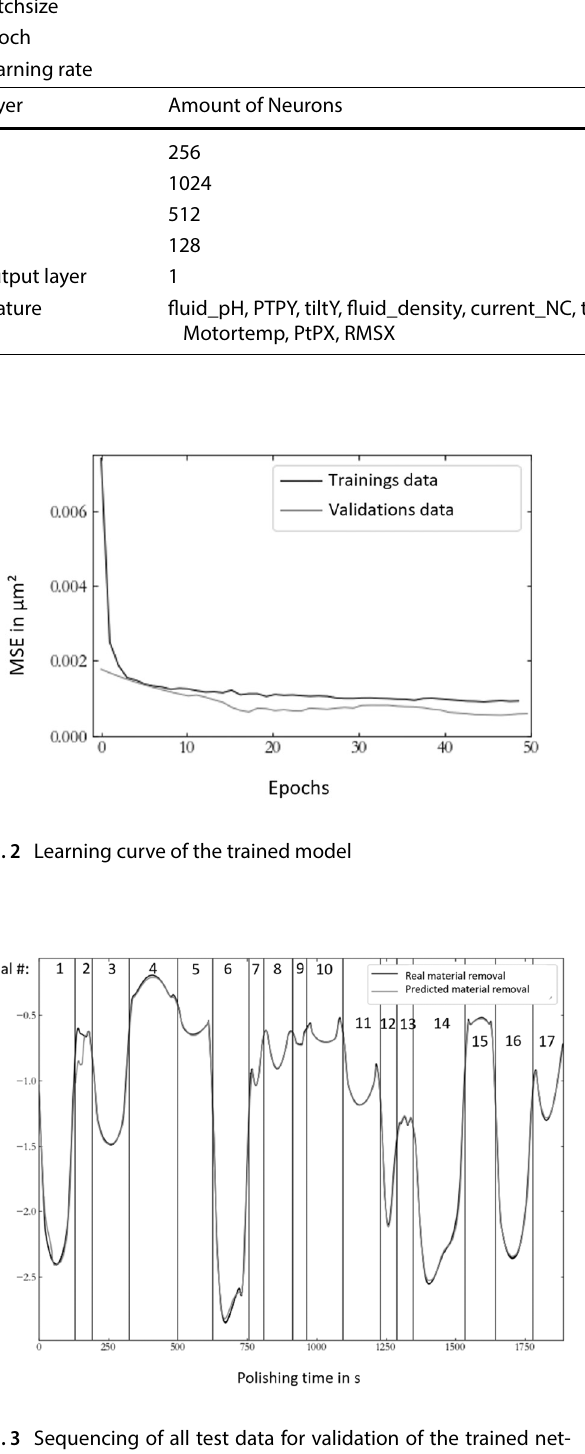
Fig. 3 Sequencing of all test data for validation of the trained net-